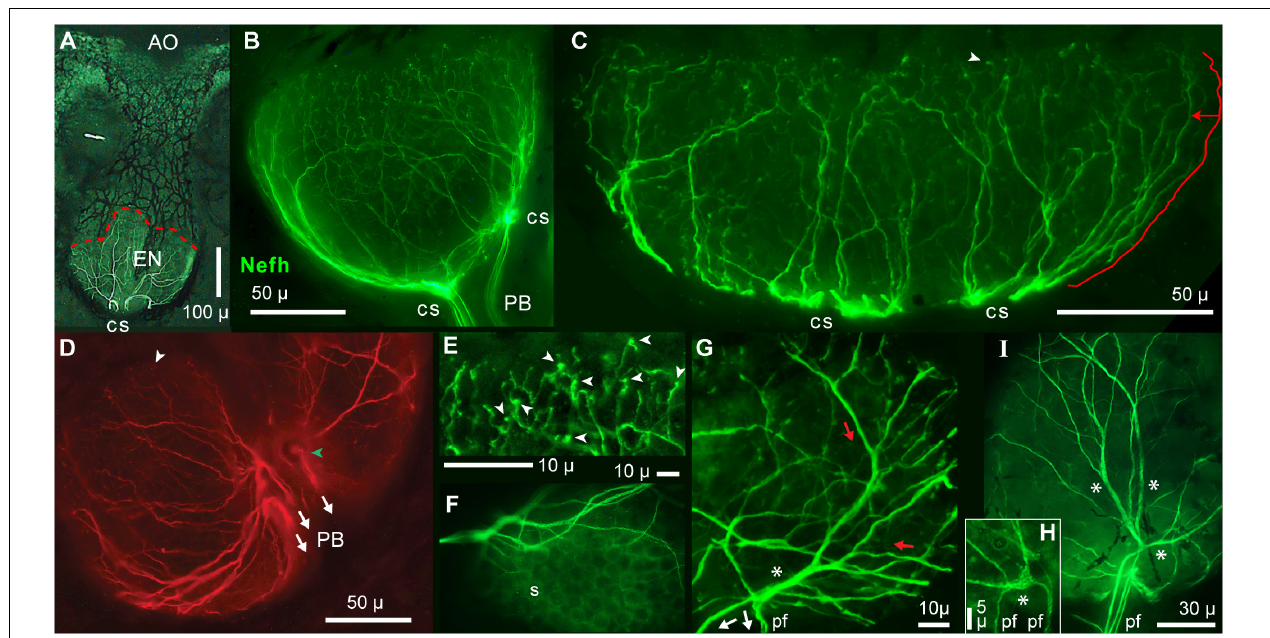
FIGURE 5 | Radial unmyelinated afferent arbors on electrosensory neuroepithelia (EN). All panels show immunolabeling of afferents by anti–neurofilament-H (Nefh). (A) Overview of a whole ampullary organ (green, brightfield) superimposed with the ramifying afferent innervation labeled by anti–Nefh (white), and basolateral contact sites (cs) of projection bundles. The dashed red line follows the EN’s superficial border. (B,C) Lateral views of afferent trees (green) on the electrosensory neuroepithelia of a small or large AO. (C) The length of the marked path along a dendrite (offset red line), to the EN’s superficial border, was measured segment-wise in ImageJ; see D ISCUSSION text. (D) This basal view of Nefh+ radial afferent trees on an EN shows connections to three fascicles of projection fibers (arrows) at focal contact sites on the basal AO face, near its center. (cid:74) , Surface marking. (E) This enlarged image of bouton-like endings (arrowheads), presumably at postsynaptic sites on receptor cells, was from the superficial (upper) edge of the arbor in (B) . Other bouton endings are marked in (C,D) (arrowheads). (F) Circular “sockets” (s) surrounded receptor cells. (G) Enlarged view of afferent “branching” on an EN. Red and white arrows show presumed directions of EPSP current flows. A basolateral segment ( ) of enlarged diameter was the centric root of an extensive unmyelinated afferent tree (red arrows) distally. This basolateral segment connected to the ends of three projection neurites (pf), identified from the full-size image. (H) This local Nefh+ swelling ( ), ∼ 3 µ across, Nefh+ throughout, was in-between three dendrites (upper) and two basal projection fibers (pf) identified from the full-size image. (I) Long enlarged Nefh+ segments ( ) ramified distally (upward) from basal contact sites of four projection fibers (pf). The elongated basolateral segments were wider (1.4–2.4 µ ) than the projection fibers leading to them (0.67–1.1- µ widths). (B–E,G–I) 40x 0.7 NA lens. (F) 60x 1.4 NA